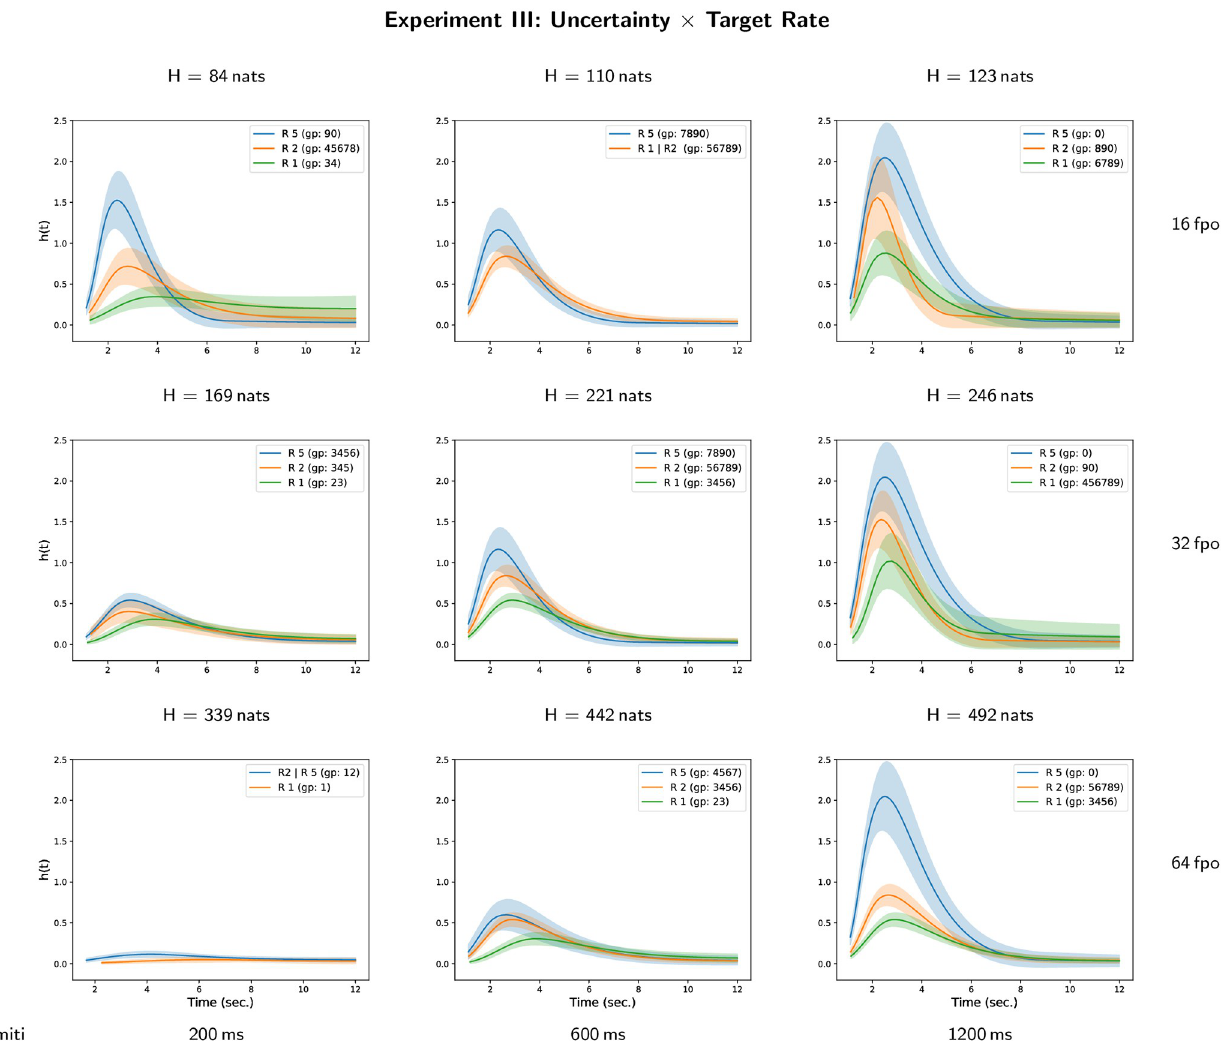
Fig 7. Hazard rate functions h ( t ) for masker uncertainty and target repetition rate in Experiment III. Each figure depicts the estimates of the hazard rate functions for each different group of the compact letter display for experimental conditions defined by the interaction between masker uncertainty and target repetition